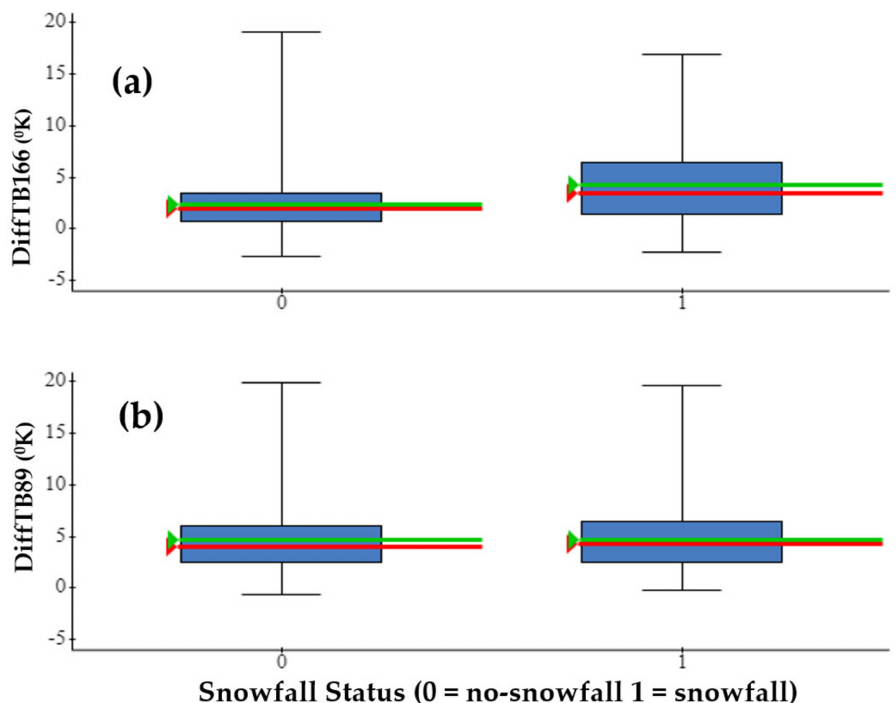
Figure 2. Boxplot of summary statistics—minimum, 25th percentile, median, mean, 75th percentile and maximum—for GMI vertical and horizontal polarization brightness temperature di ff erence at ( a ) 166 GHz (Di ff TB166) and ( b ) 89 GHz (Di ff TBTB89) for the snowfall and no-snowfall sample. The green line indicates the mean value and the red line indicates the median